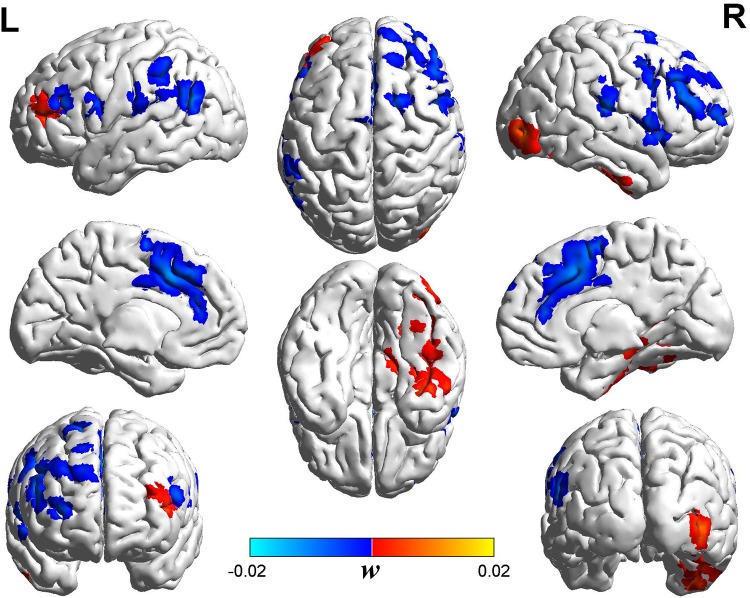
Discriminative ReHo-map for minimal hepatic encephalopathy (MHE) subjects.The map is composed of 4,000 features as the optimized classification performance is achieved. The color intensity indicates the attribute weight of a feature in support vector machine (SVM) classification. The map shown includes clusters with > 50 voxels. The positive and negative weights indicate relatively increased and decreased ReHo values, respectively, in MHE patients as compared to NHE group.